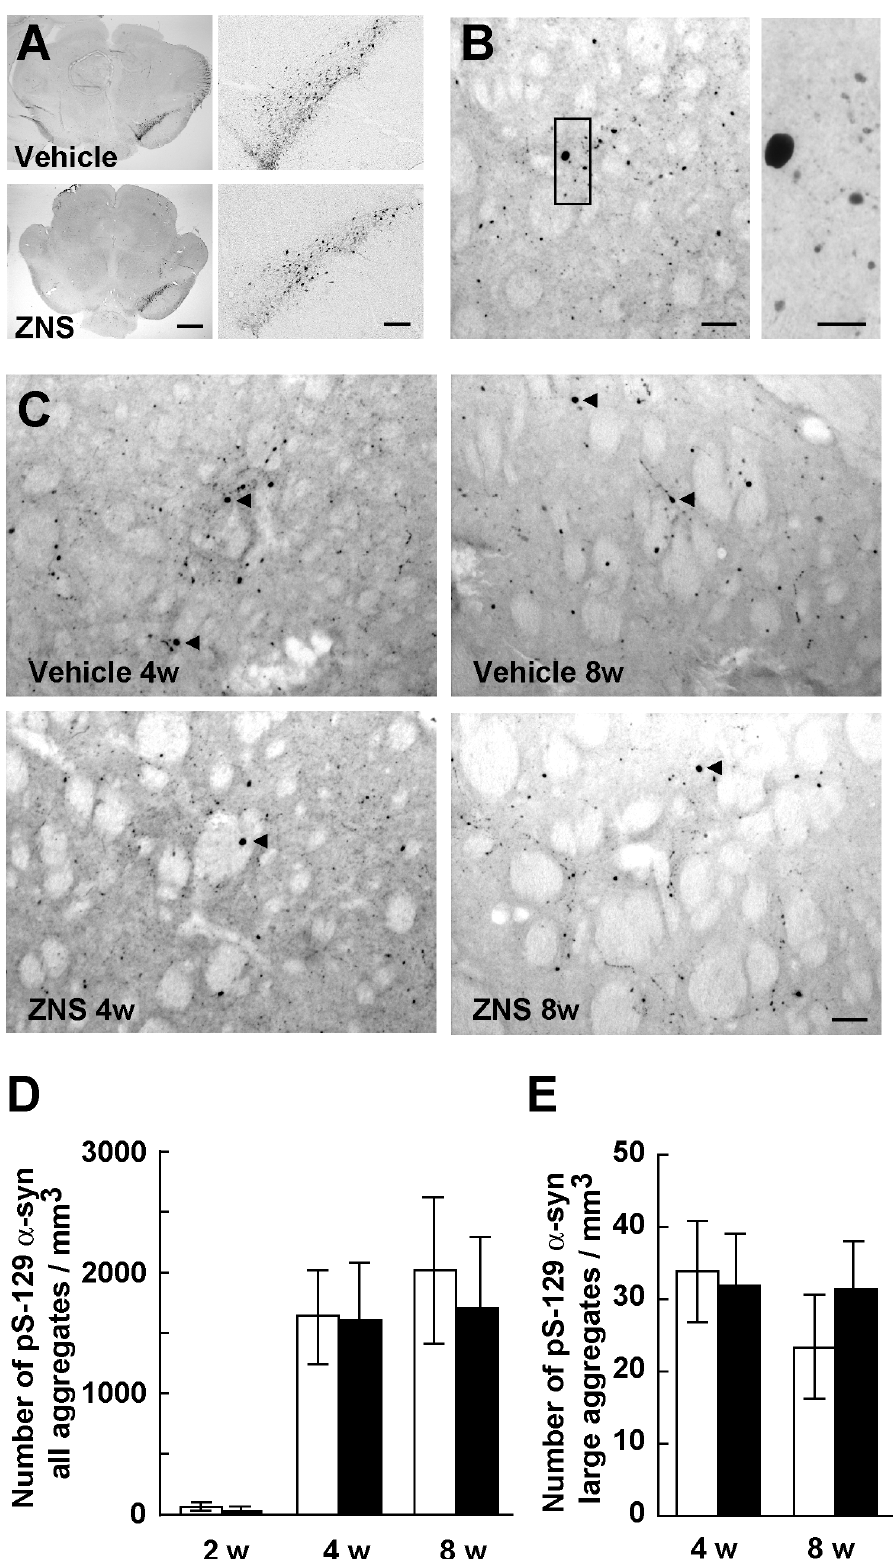
Figure 6. Analysis of Ser129-phosphorylated a -synuclein-positive aggregates in the striatum. ( A – C ) The sections were immunostained with antibody that specifically recognizes Ser129-phosphorylated a -synuclein. ( A ) Photomicrographs show representative immunostainings of the injected and uninjected sides of the substantia nigra at 2 weeks after rAAV-A53T a -synuclein injection. Left panels show images at low magnification, and right panels show enlarged images of the injected side of the substantia nigra. Scale bars indicate 1 mm and 200 m m in left and right panels,